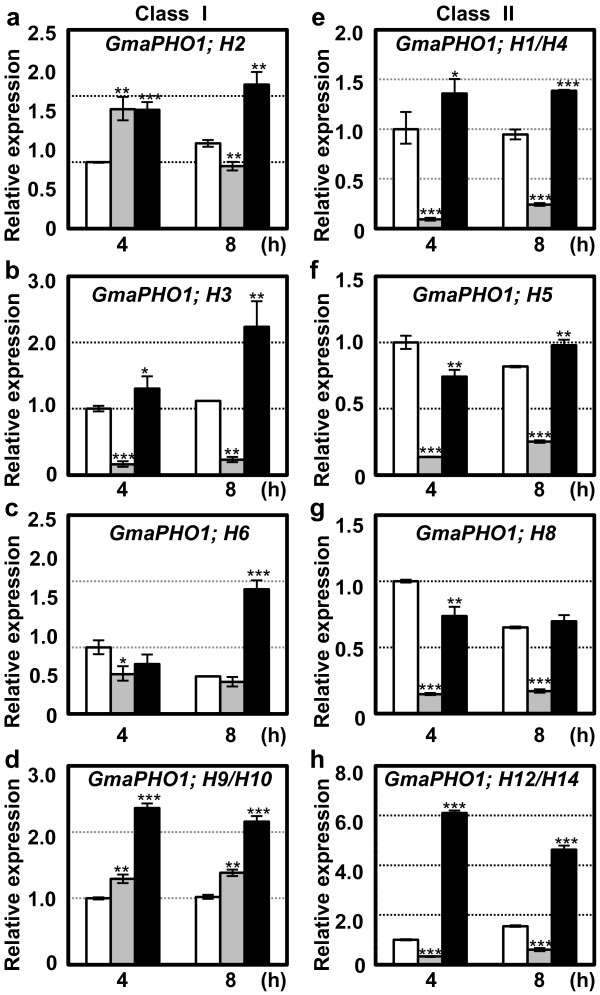
Expression of GmaPHO1 genes in response to salt and drought stresses. (a-d) Root expression of the Class I gene in response to PEG-6000 (grey column) or NaCl (black column). (e-h) Root expression of the Class II gene in response to PEG-6000 (grey column) or NaCl (black column). Genes are indicated in each graph. Empty column represents the untreated control. The 3-week old seedlings of ‘Nannong1138-2’ were treated with for 4 h and 8 h. Actin was used as an internal control. The experiments were performed based on three independent biological samples. Error bars=standard deviations. Star indicates the significance of gene expression variation under each treatment in comparison to the untreated control (*P < 0.05, **P < 0.01 and ***P < 0.001).